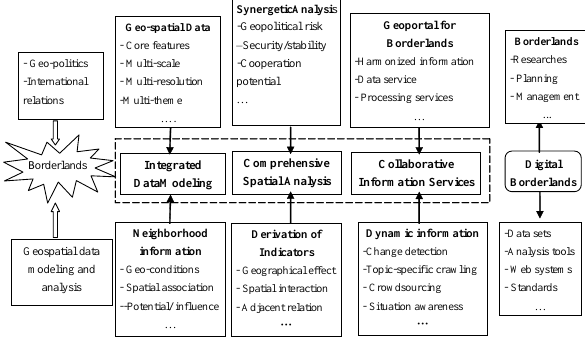
Figure 1 The framework of borderlands modelling and